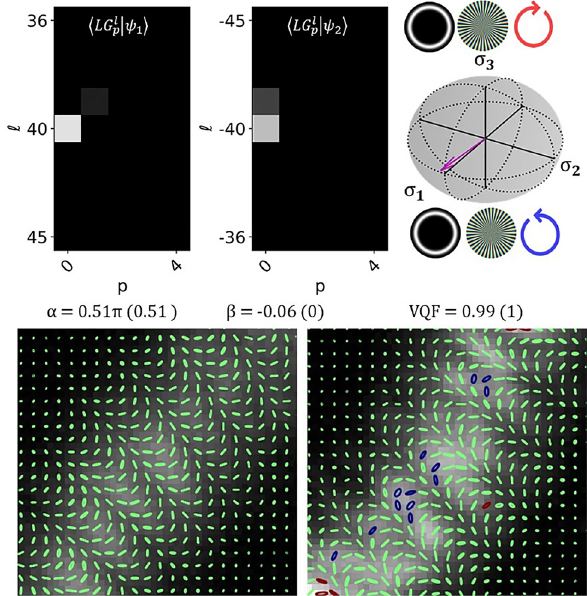
Figure 5: Crosstalk matrices and state vector lying on the HOPS ⟩ = LG 40( − 40) (top left). HOPS sphere for l ± 40 with sphere for | 𝜓 1(2) 0(0) the state vector (top right). Cropped regions displaying the